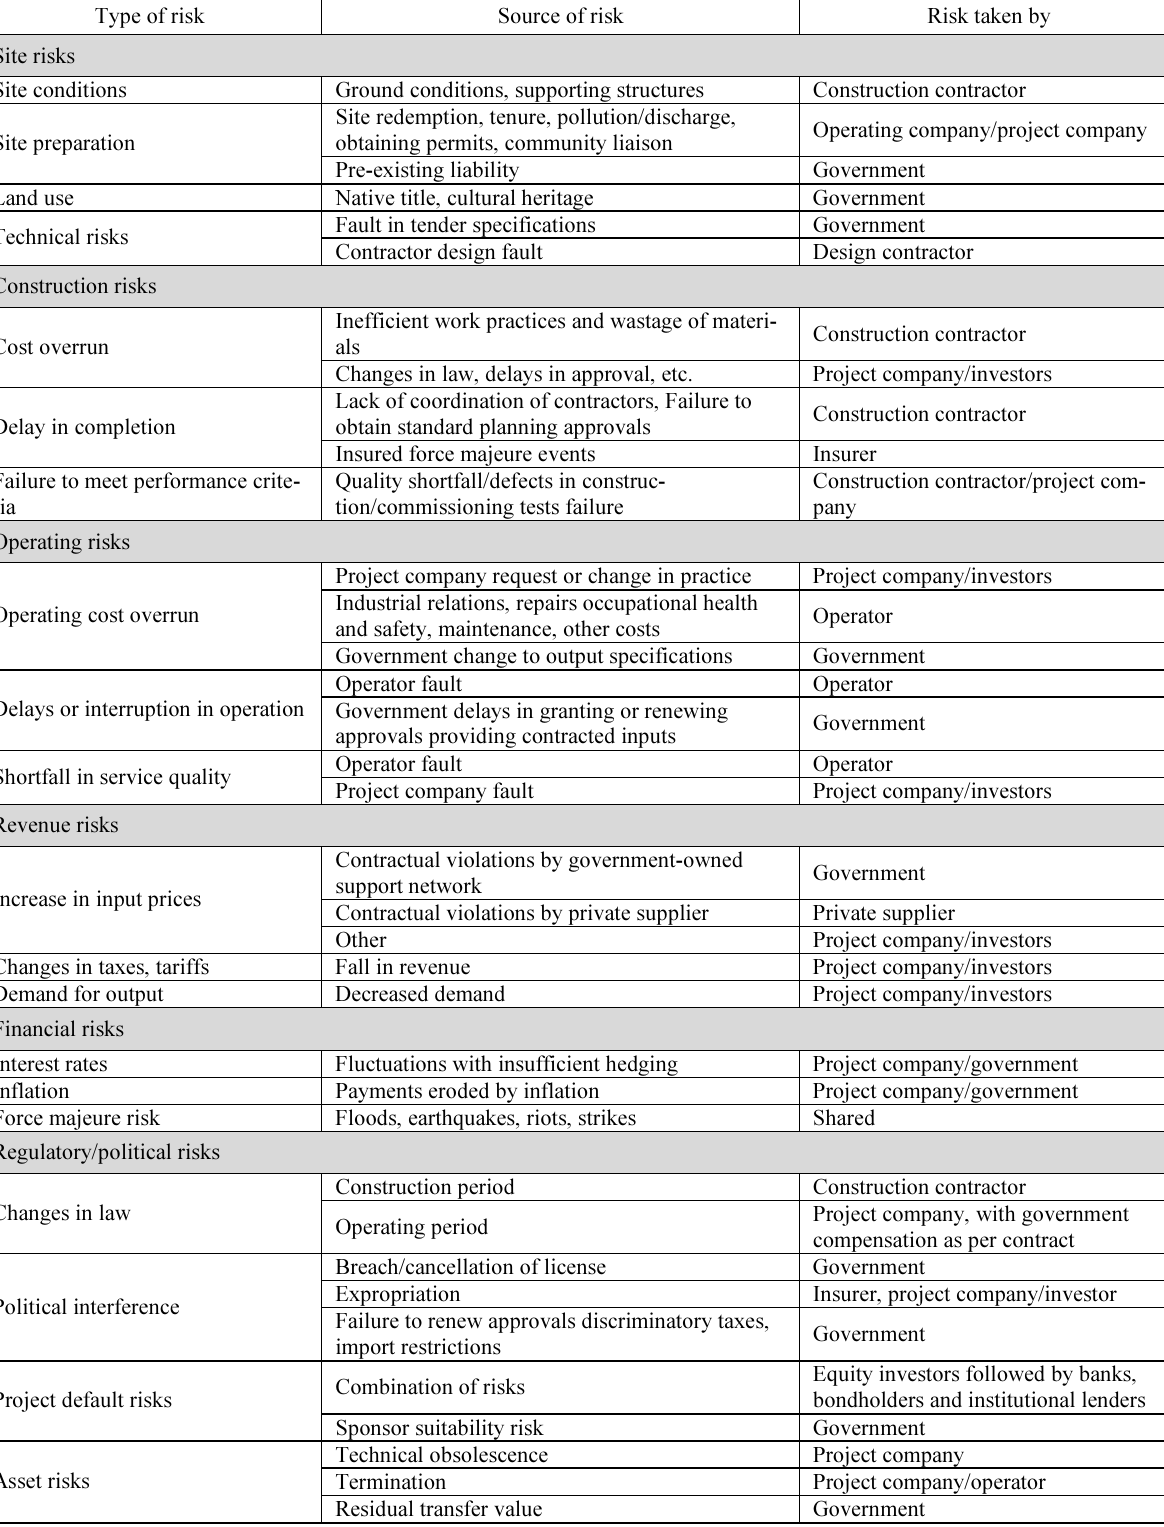
Table 1. A general risk sharing matrix for the public and private sectors in PPP projects (Grimsey and Lewis